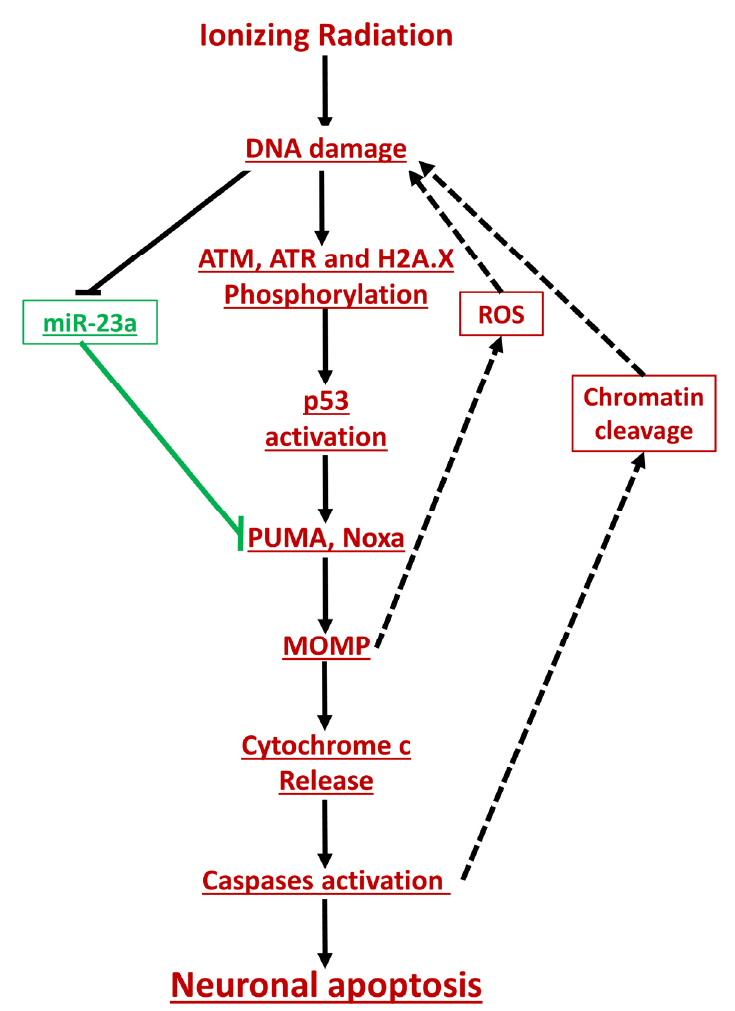
Figure 9. The schematic illustration of the role of miR-23a on the IR-induced neuronal outcome. Pro-apoptotic events are shown in red, anti-apoptotic events are shown in green. Confirmed changes are underlined and shown in solid arrows.